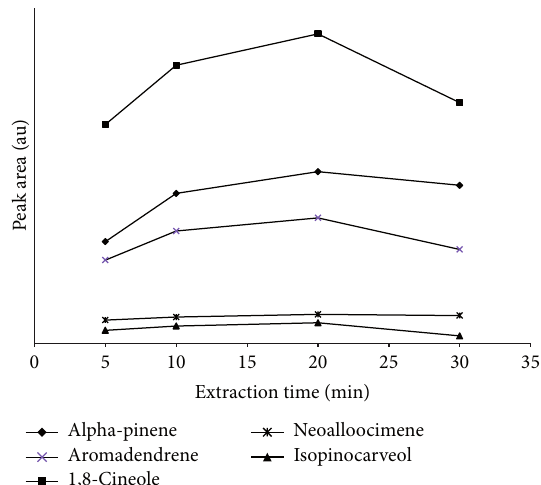
IsopinocarveolNeoalloocimene F 5: Optimization of extraction time, 0.2g powdered Eucalyp- C extraction tus leaf, and 60 ∘